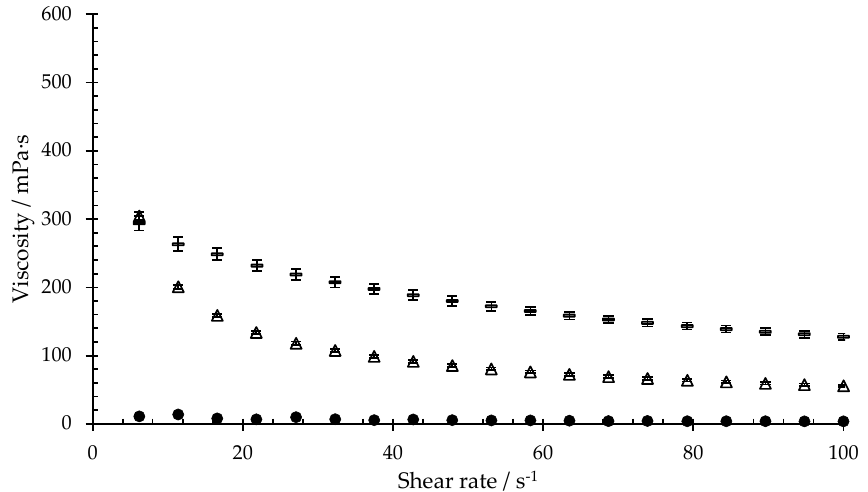
Figure 3. Viscosity of artificial saliva, 0.35% xanthan gum, and 0.65% sodium hyaluronate at a shear rate range of 1–100 s − 1 and 33 °C (19 data points, linear ramp), • artificial saliva, (cid:52) 0.35% xanthan gum, ─ 0.65% sodium hyaluronate. Mean ± standard deviation. Each sample was measured in triplicate.